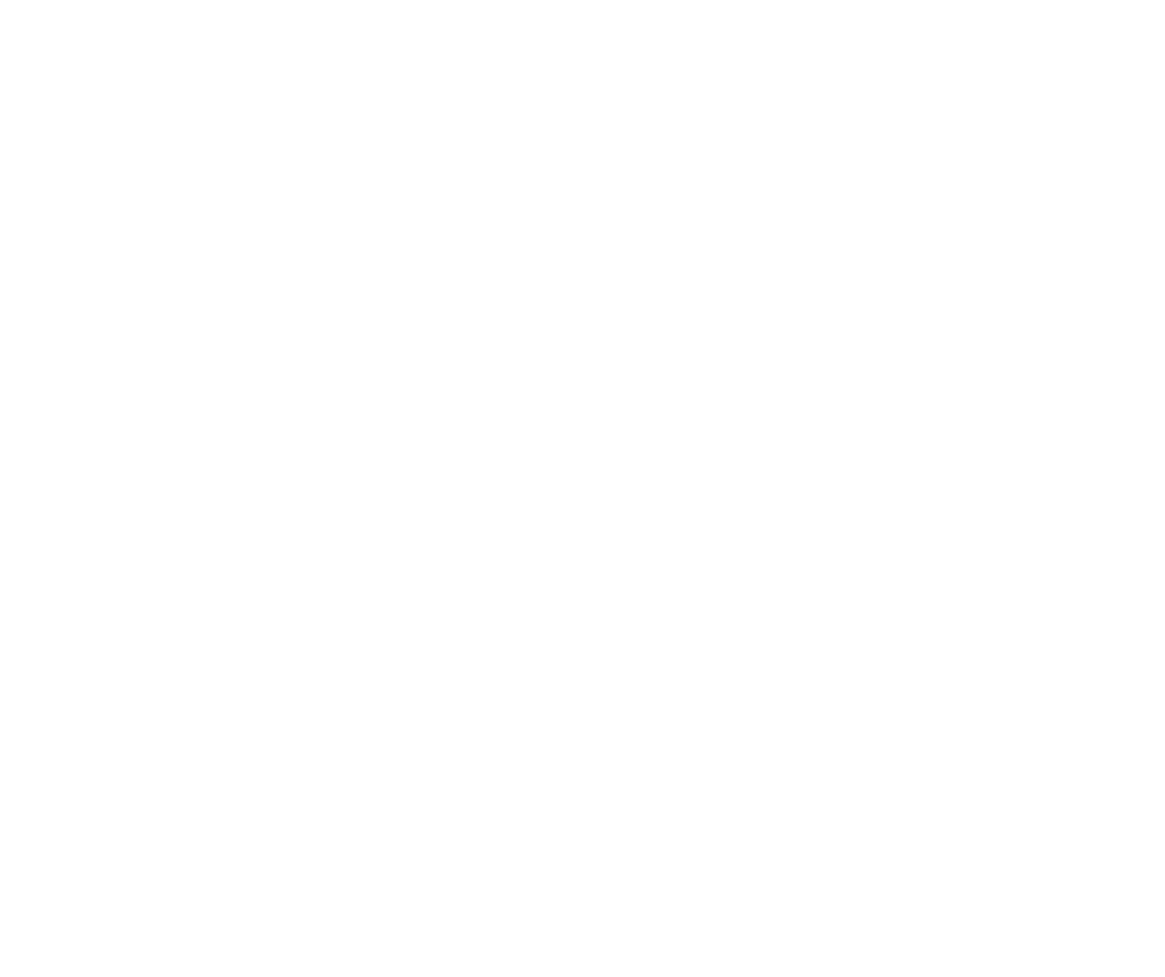
FIGUREA14 | (A) BB7.2 pulldown and acid extracted peptide pool fromTAP-deficientT2 cells showing prominent GILT signal peptides at m / z 449.78 (LLDVPTAAV 2H + ), m / z 460.77 (LLDVPTAAV Na + H + ), and m / z 605.88 (LLLDVPTAAVQA 2H + ). (B) BB7.2 pulldown and acid